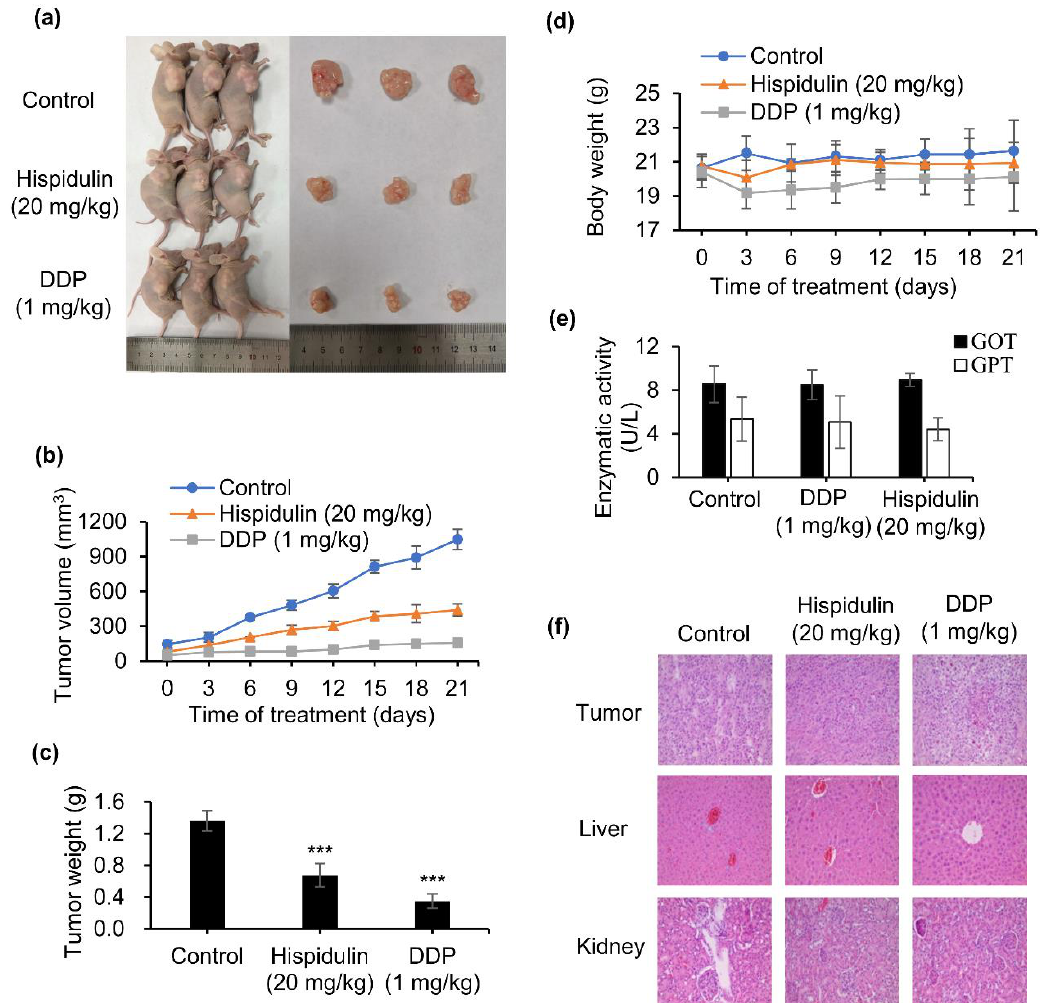
Figure 5. Hispidulin suppressed tumor growth in a xenograft model with CNE-2Z cells. ( a ) Representative images from each treatment group at the end of the experiment. ( b ) Tumor volumes of the mice were estimated. ( c ) The mice were sacrificed and the tumors were weighed. ( d ) Body weight of the mice was measured. ( e ) In vivo hepatotoxicity evaluation of hispidulin by glutamate oxaloacetate transaminase (GOT) and glutamate pyruvate transaminase (GPT) levels of blood serum samples, determined by assay kit. The GPT and GOT activities are expressed as U/L. ( f ) Hematoxylin and eosin (H & E) staining (original magnification 200×) of the tumor, liver, and kidney from the mice after treatment. *** p < 0.001 vs. control.